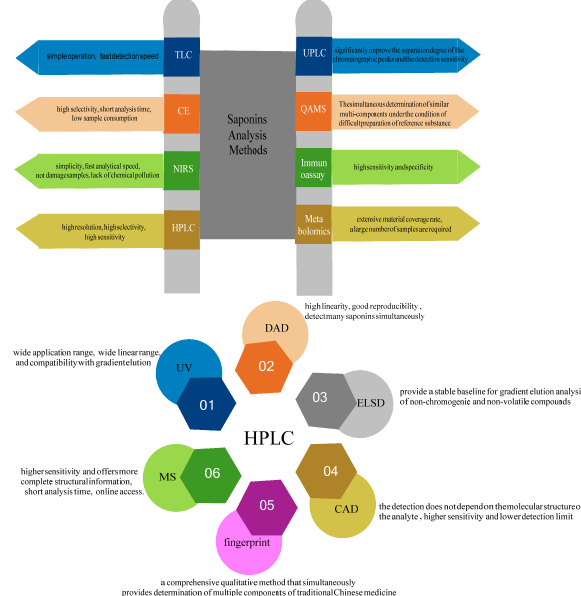
Figure 11. Characteristic diagram of the saponin analysis method.